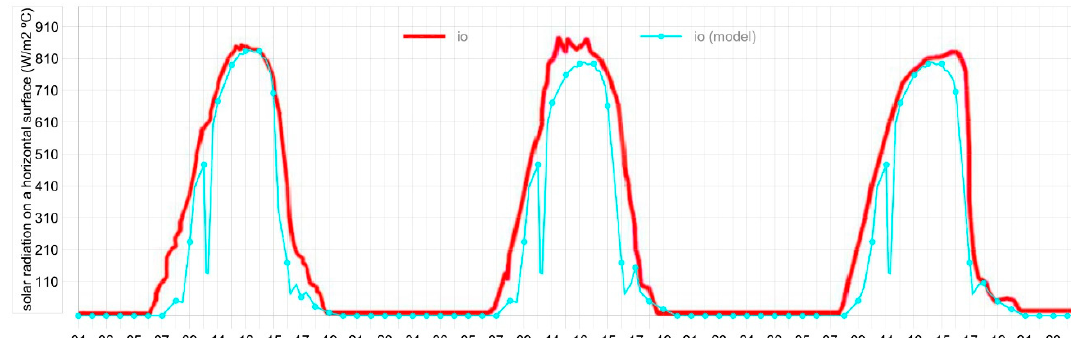
Figure 7. Solar irradiance. Comparison results of simulation data and measured data of the solar irradiance of the prototype. Sample summer days: 23/08/2010, 24/08/2010, and 25/08/2010.